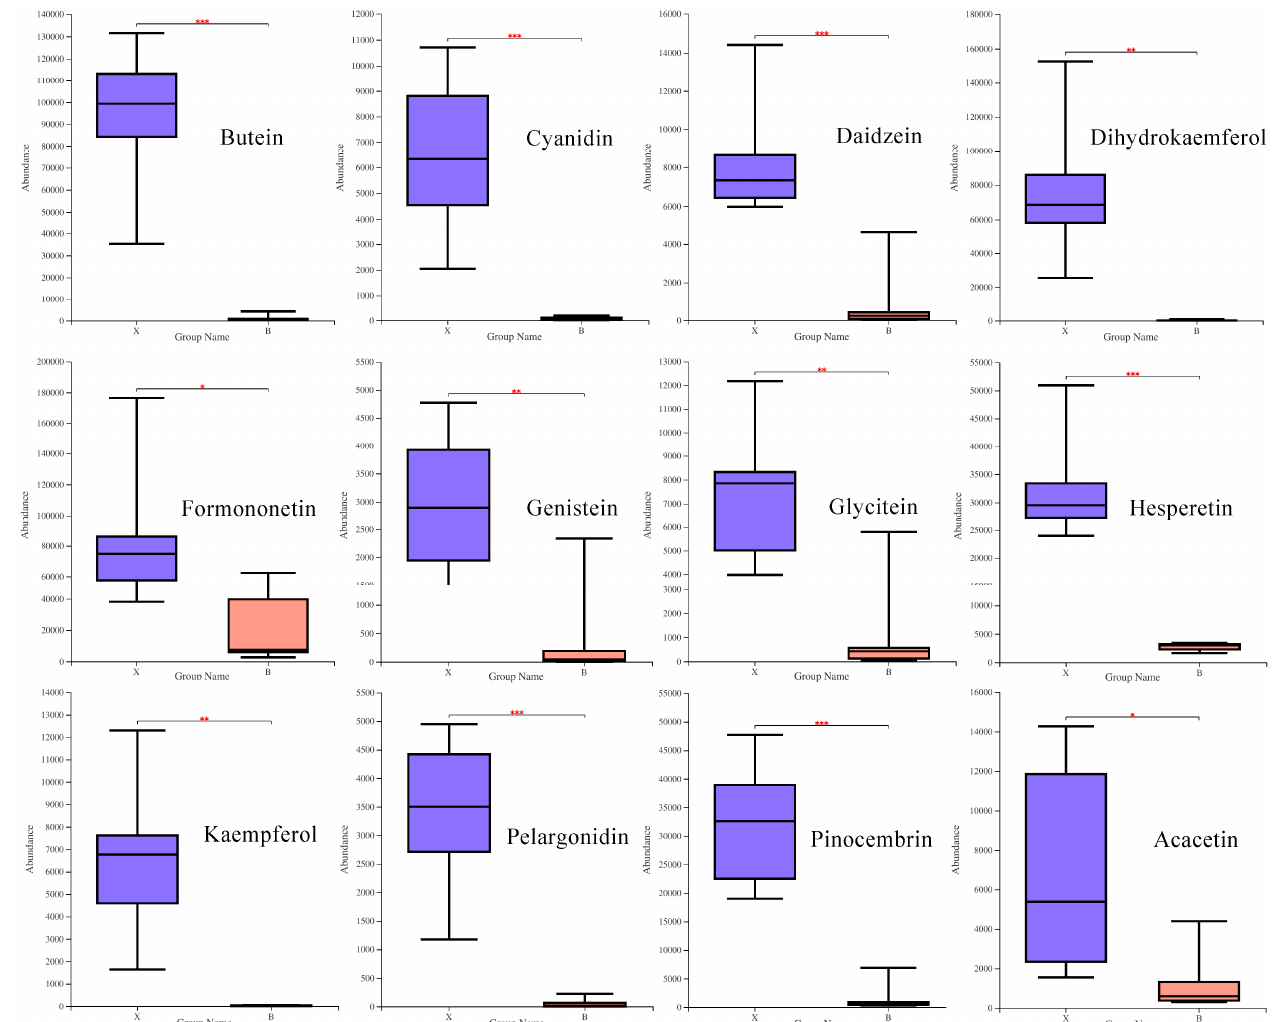
Figure 9. The relative contents of major differential metabolites. Groups X and B indicate the heartwood and sapwood groups, respectively. The line in the middle of the box represents the median relative expression abundance of the metabolite, and the upper and lower edges represent the maximum and minimum values of that set of data. Upper side * represents p < 0.05, ** represents p < 0.01, and *** represents p < 0.001.